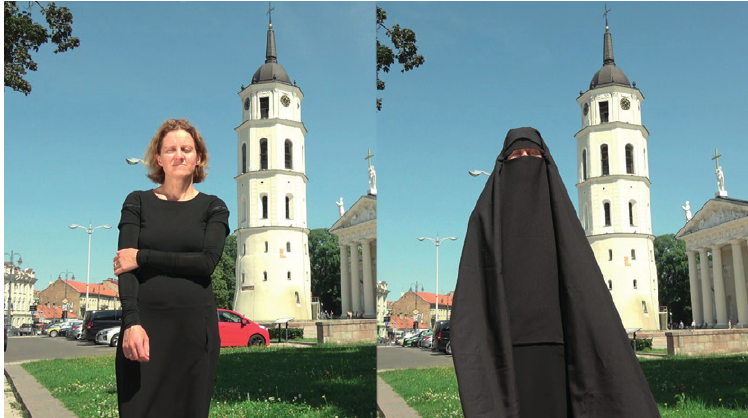
Figure 6. Sigita Maslauskaitė-Mažylienė. Partition: Niqab (2017)